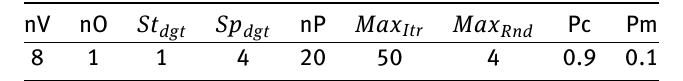
Table 17: VSSCGA Settings for Rosenbrock’s function with 8 variables